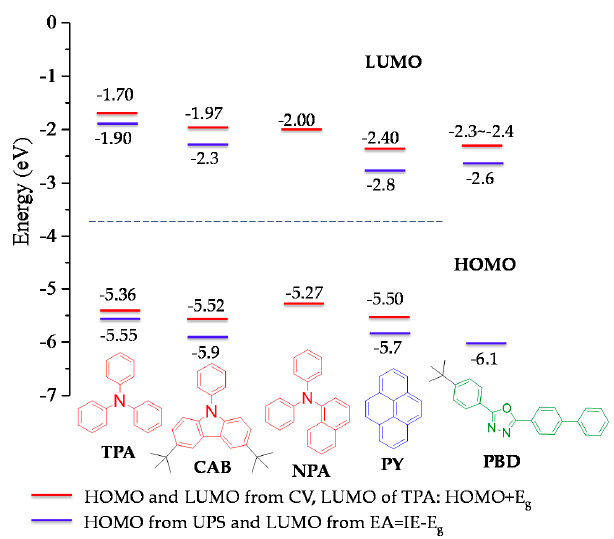
Figure 6. HOMO and LUMO levels of PCs and pyrene estimated from CV of dendrimers and literature (red) [24,59], from reported UPS measurements [23,37,60,61].